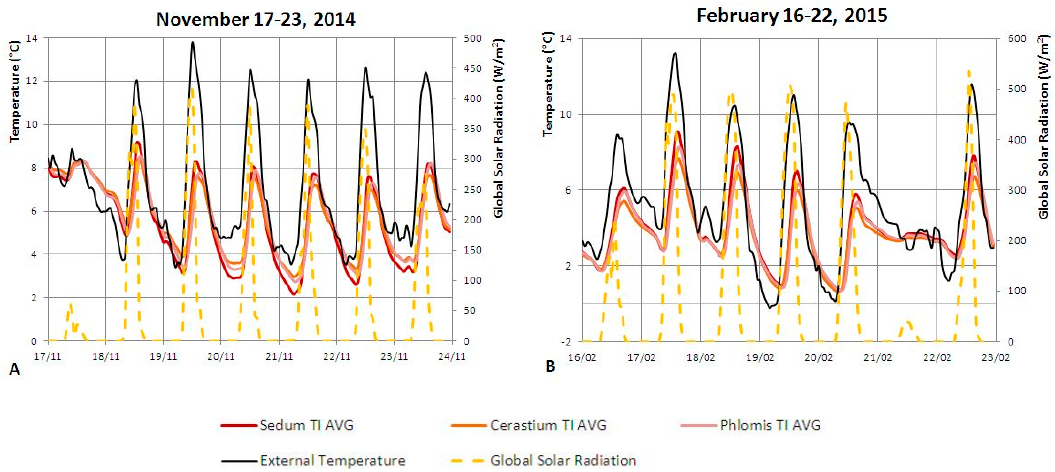
Figure 11. Inside temperature of the growing medium (T i ) trend as a function of the global solar radiation (W/m 2 ) and the external temperature (T e ): ( A ) autumn 2014; ( B ) winter 2014–2015. Inside temperature trends reflect the outdoor ones: Sedum T i is higher than the two other planted species, followed by Phlomis . Differences are, however, slight (about 0.5 °C) and inside temperatures tend to overlap, due to a very low thermal gradient.